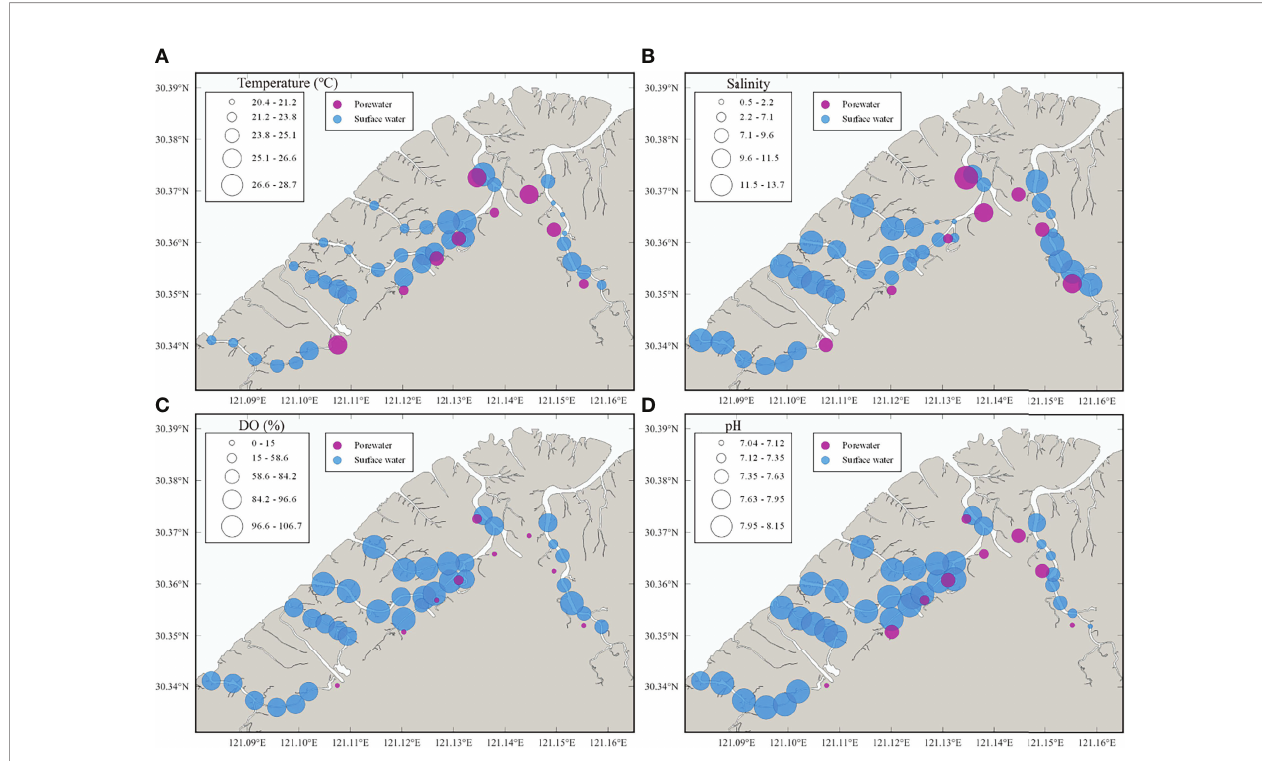
FIGURE 2 | Spatial distributions of (A) temperature, (B) salinity, (C) DO and (D) pH in surface water and